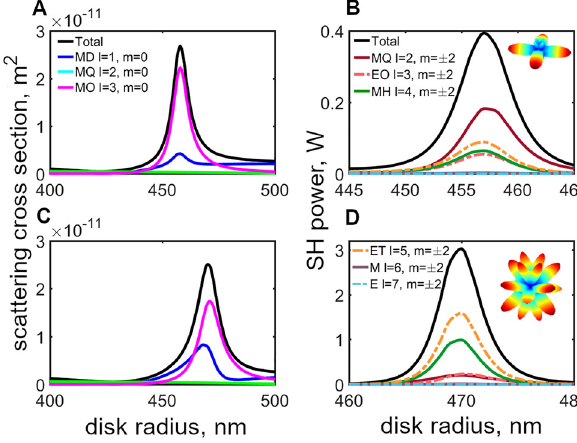
Figure 6: Multipolar decomposition of linear scattering (A,C) and Figure 5: Maps of linear scattering of the AP beam by the AlGaAs second-harmonic generation (B,D) spectra for two slices in Figure 5. nanodisk (A) and the SH generated power (D). Panels (B) and (C) Top and bottom panels correspond to pump wavelengths λ 0 = 1580 correspond to magnetic dipole and octupole contributions to the and 1600 nm, respectively. Colored lines show different multipole linear scattering. Solid pink lines correspond to the dispersion contributions to the linear scattered and the second-harmonic curvesofFFeigenmodes,solidbluelineisthedispersioncurveofSH fi elds.Insetsshowfar- fi elddiagramsofSHradiationattheBICpoint mode. Pink dot marks a BIC state. Dashed lines are two slices of ( λ 0 =1580nm, r =457nm, h =645nm)andatthepointofdispersion λ λ 0 = 1580 nm and 0 = 1600 nm. Insets in the panel (D) show electric curves intersection ( λ 0 = 1600 nm, r = 470 nm, h = 645 fi eld distribution at the BIC point (in the pink frame) and at point of intersections of dispersion curves (at maximum SH power) (in the yellow frame).